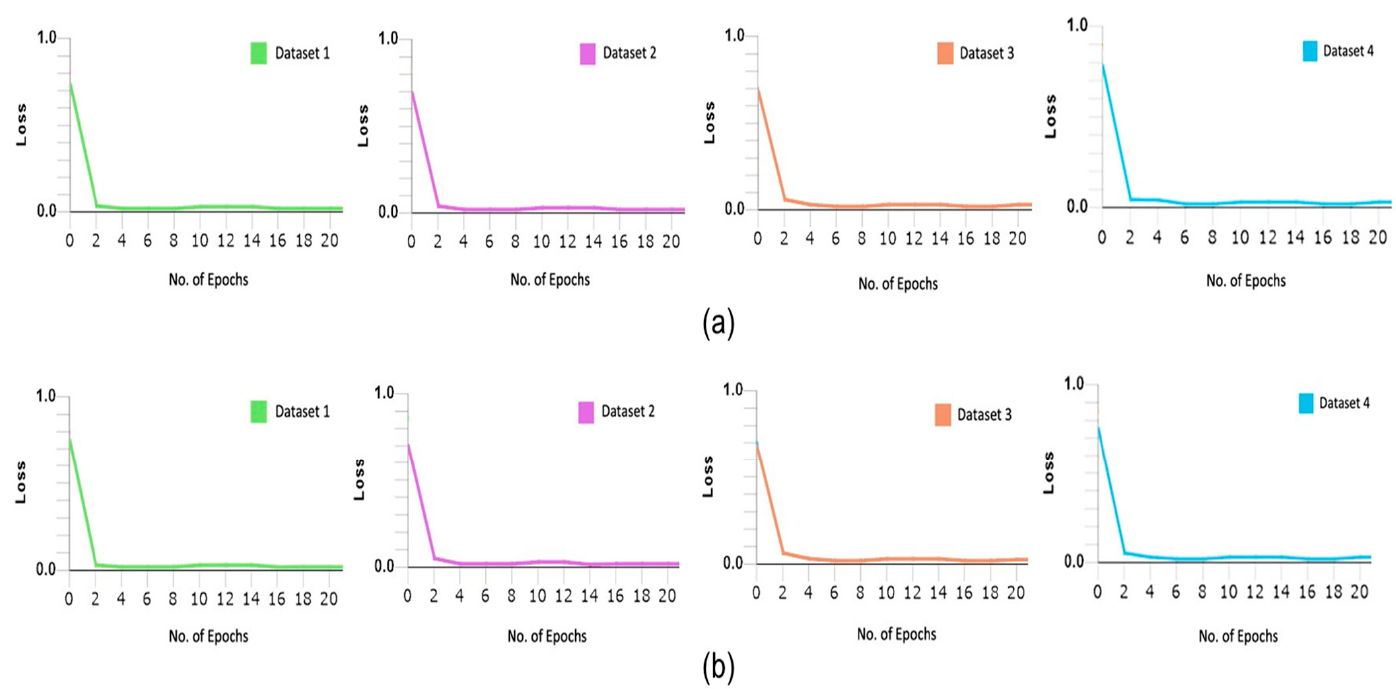
Figure 7. Fast convergence ability of the proposed method: ( a ) training loss curves and ( b ) validation loss curves.